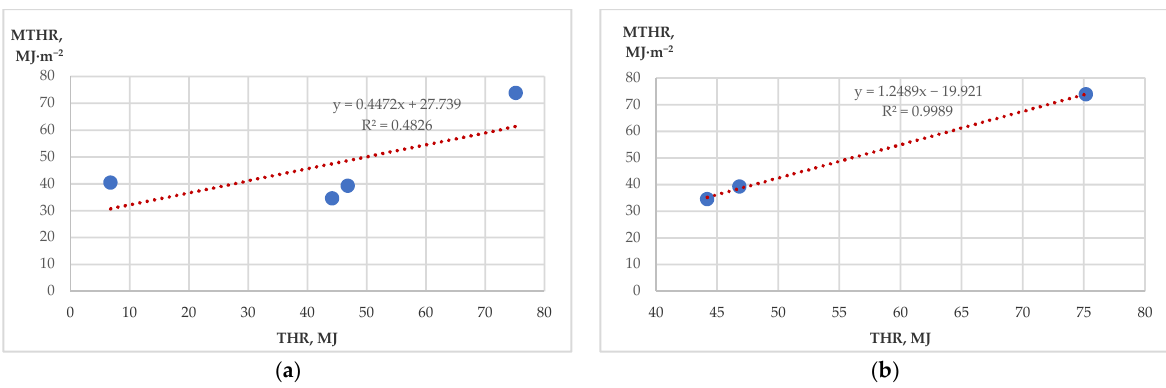
Figure 14. The linear correlations of MTHR and THR results for ( a ) specimens 1, 2, 3, 4, and ( b ) specimens 1, 2, 4.